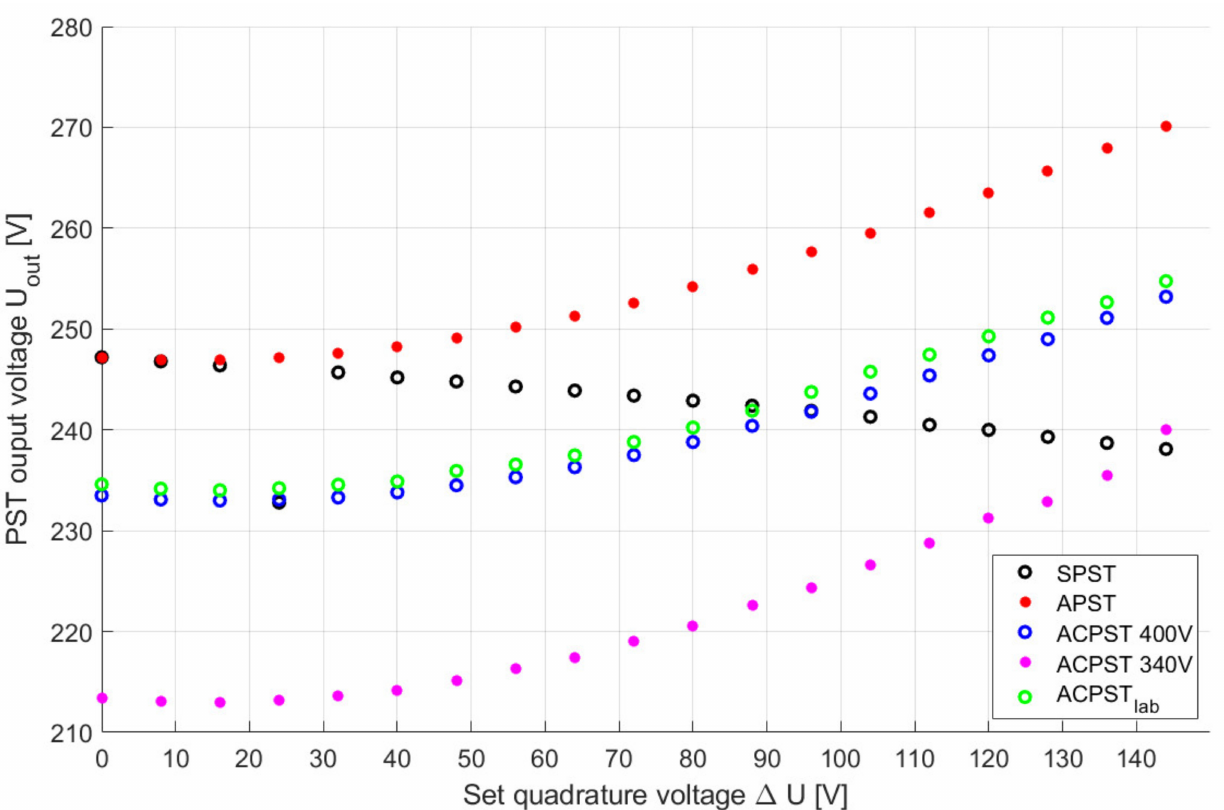
Figure 14. PST output voltage in function of the set quadrature